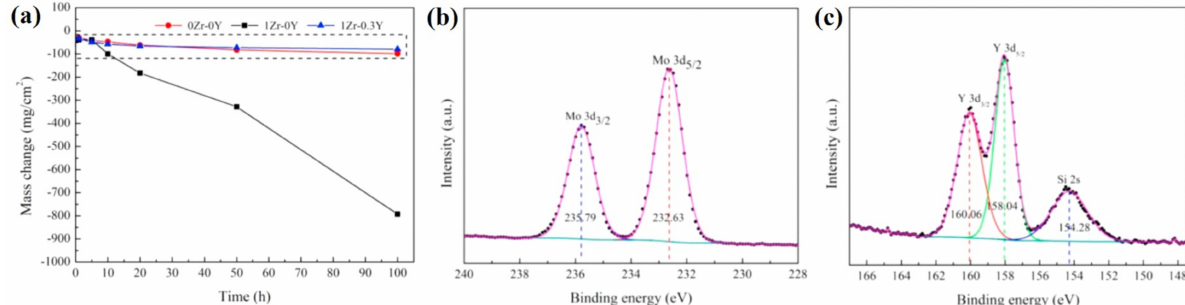
Figure 11. Mass change curves of three studied samples at 1250 ◦ C ( a ); XPS analysis of Mo ( b ) and Y ( c ) characterized the 1Zr-0.3Y sample surface oxidized for 1 h. Reproduced with permission [135]. Copyright 2020